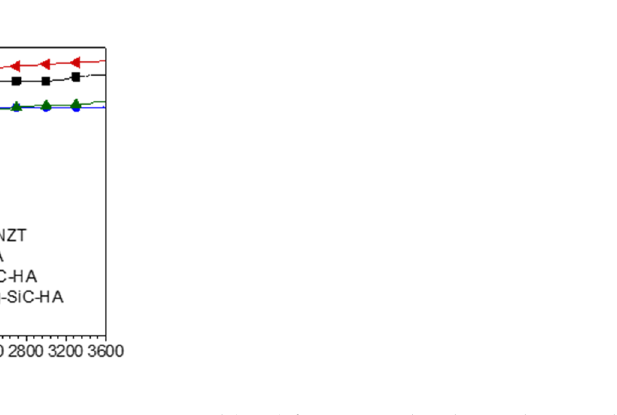
Figure 8. The time evolution of the open circuit potential (E OC ) for uncoated and coated TNZT alloy. The TNZT alloy was quickly oxidized, as the transitional metals from the periodic groups IVB and VB are known to be prone to oxidation. It should be noted that TNZT alloy saliva solution doped with NaF and different pH values [68], Fusayama-Mayer artificial saliva or SBF [13].